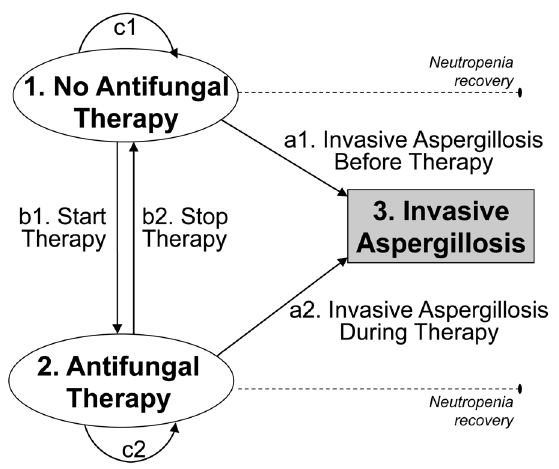
Figure 1. Multi-State Model of Invasive Aspergillosis and Antifungal Therapy in Febrile, Neutropenic Patients with Acute Myeloid Leukemia.